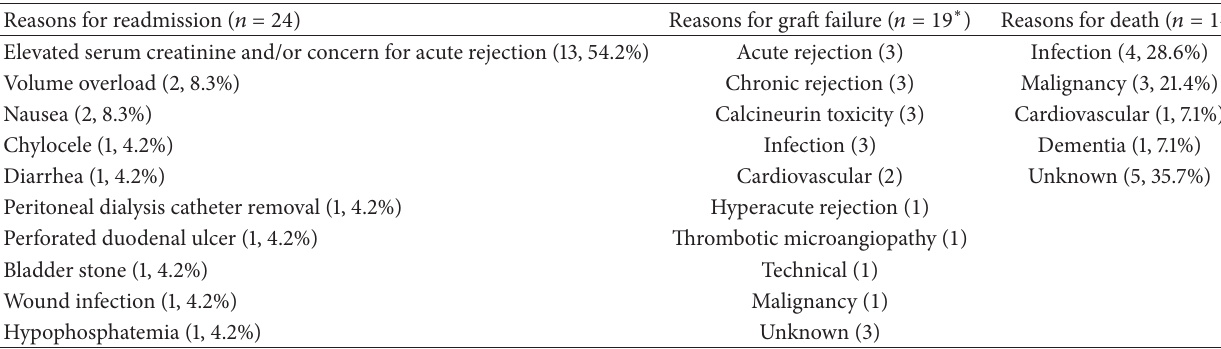
Table 4: Reasons for readmission within 30 days of discharge, graft failure, and death in transplant recipients. Reasons for readmission ( 𝑛 = 24